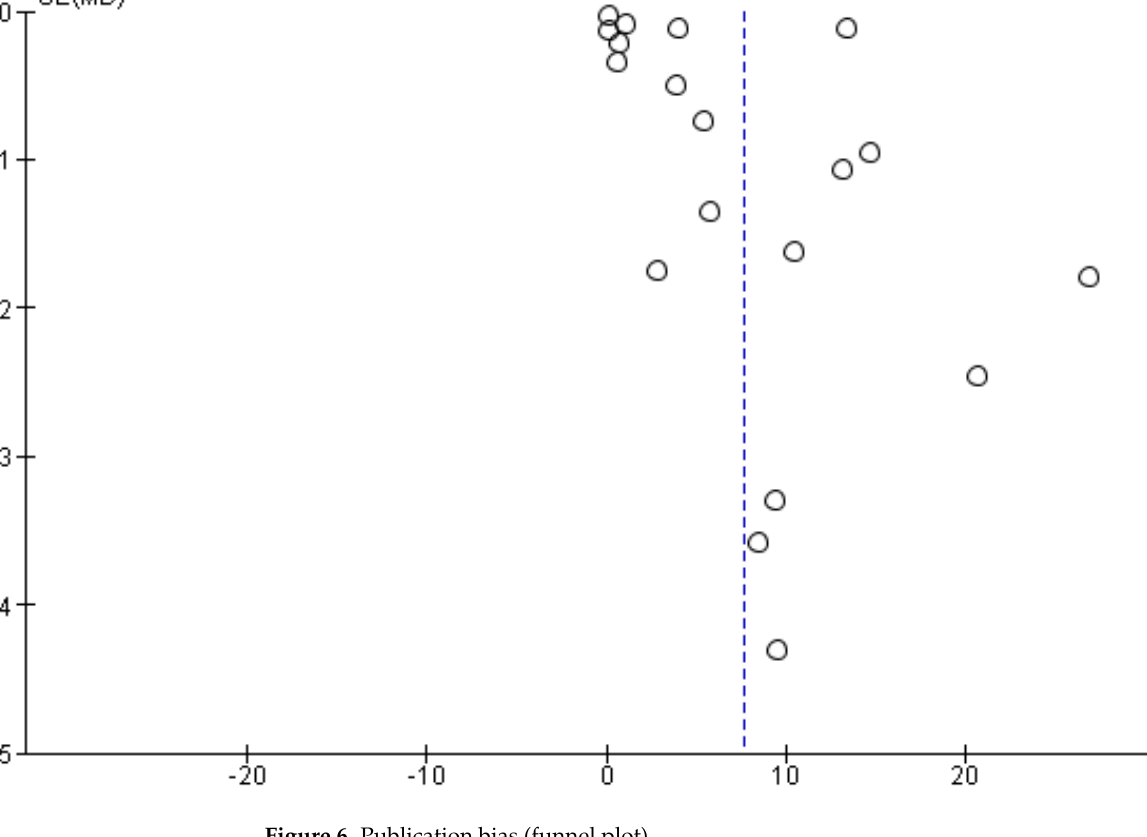
Figure 6. Publication bias (funnel plot).